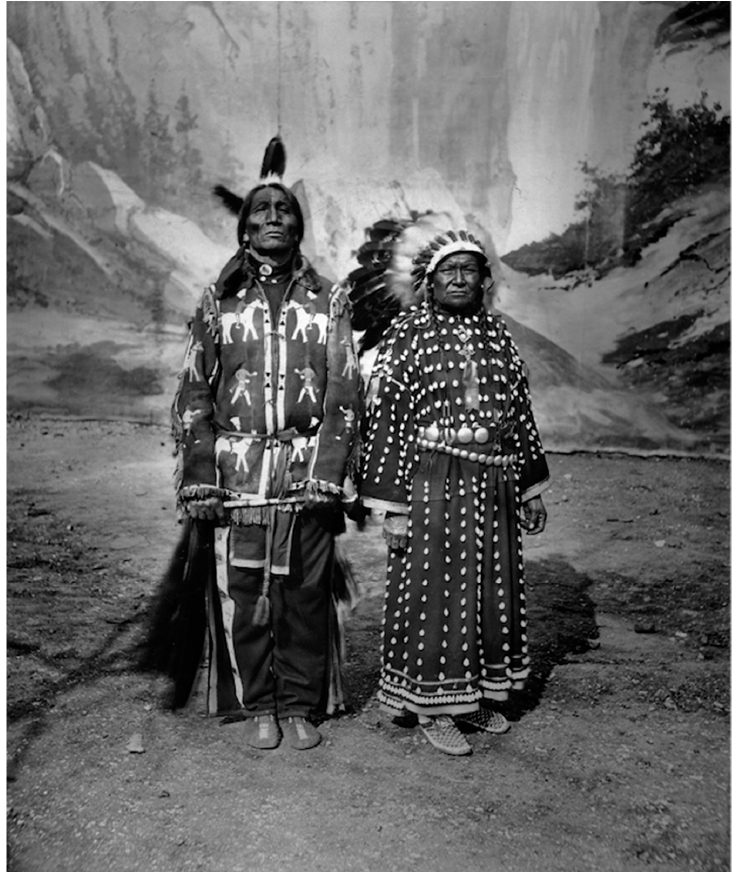
Figure 12. It ȟ ú ŋ kasa ŋ Glešká and Ȟ an ŋ té It ȟ ú ŋ kasa ŋ Glešká in London, 1909, photographic print, 29 cm × 24 cm, Denver Public Library, X-32146. Photograph used by permission of Denver Public Library.